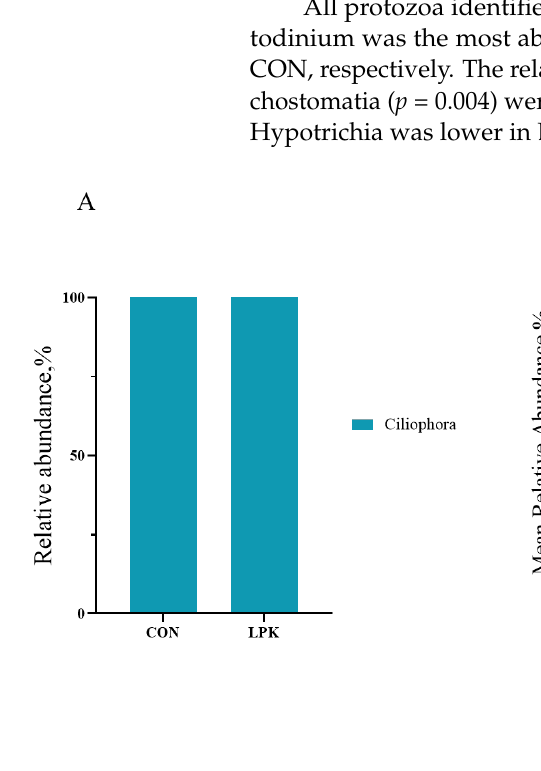
Figure 5. The rumen fungal community in Hu sheep: ( A ) The mean relative abundance of phylum ≥ 1% in at least one group is present. ( B ) The mean relative abundance of genus ≥ 1% in at least one group is present. Error bars, SEM. * p < 0.05. CON = control group; LPK = live Pichia kudriavzevii group.